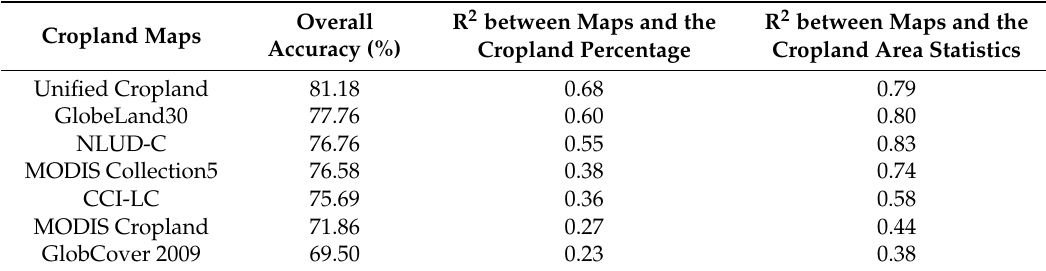
Table 1. Accuracy and consistency with cropland percentages and statistics of the seven harmonized cropland